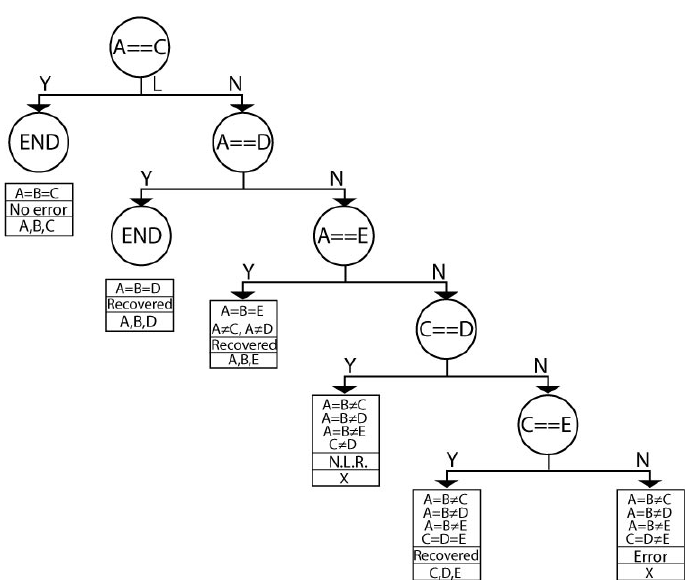
Figure 5. Sub-tree L for evaluating the remaining comparators according branch Y from tree P .